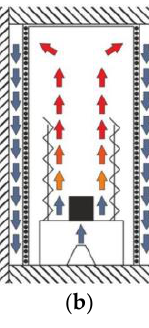
Figure 4. HIP; ( a ) Quintus-QIH9 model and ( b ) URQ ® technology.